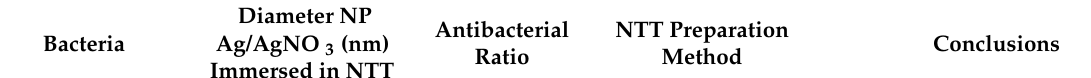
Table 1. Antibacterial activity of NP Ag incorporated into